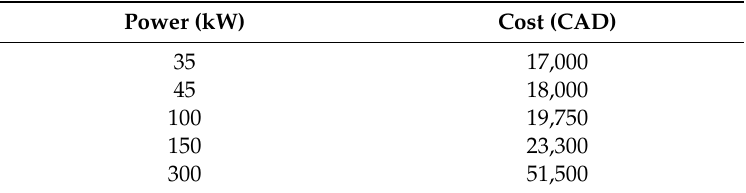
Table 11. Summary of generator costs [95].